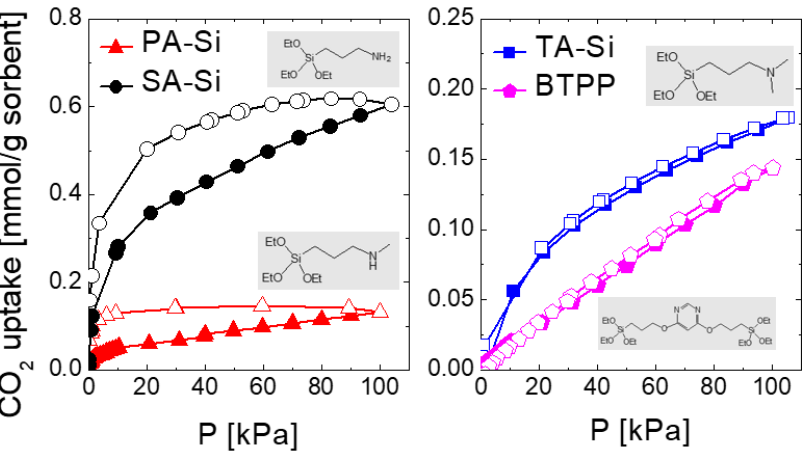
Figure 10. CO 2 adsorption/desorption isotherms at 35 °C for amine-functionalized organosilica xerogel powders. The solid symbols represent the adsorption data, and the open symbols show desorption. Results were reorganized from refs. [21,22].